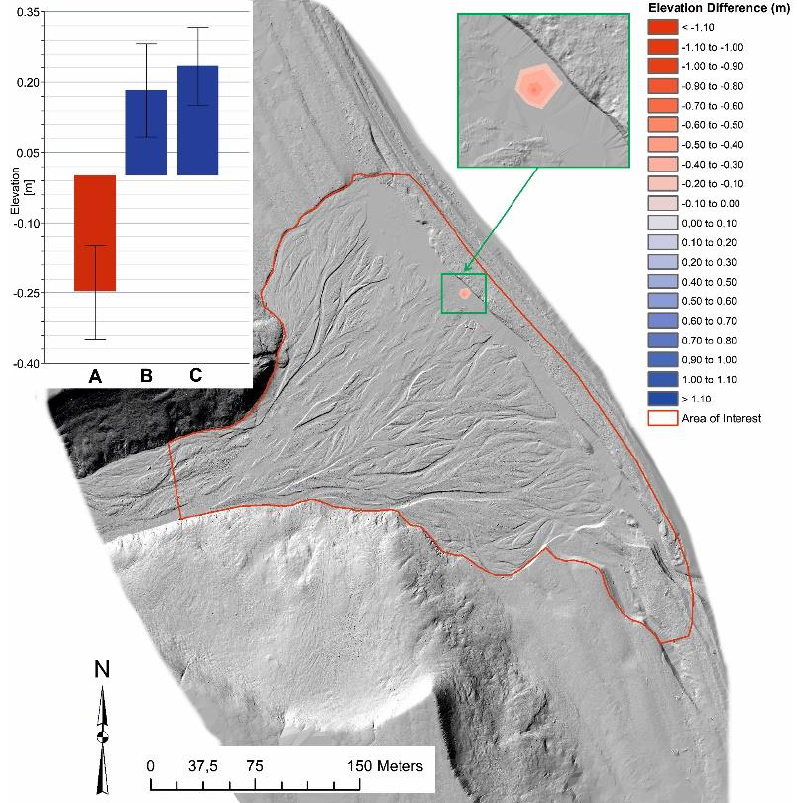
Figure 4. Digital elevation model (DEM) of difference (DoD) for the AoI (July 2010 with MinLoD = 0.1). Hillshade map is shown behind the DoD for context. Description of the bars in the diagram: (A) Average Depth of Lowering; (B) Average Depth of Raising; (C) Average Total Thickness Difference. Table 2. Changes in physical parameters of the Area of Interest in July 2010 calculated volumetrically with reference to the total volume of the gravel-cobble material’s net change recorded by the DoD (both lowering and raising) from the manually cleaned-up (new) to the CSF-filtered (old) DTM. The uncertainty analysis was calculated by simply using the minimum level of detection (minLoD) approach while accounting for a uniform error of 0.1 m. Attribute Raw Thresholded DoD Estimate: Areal Metrics